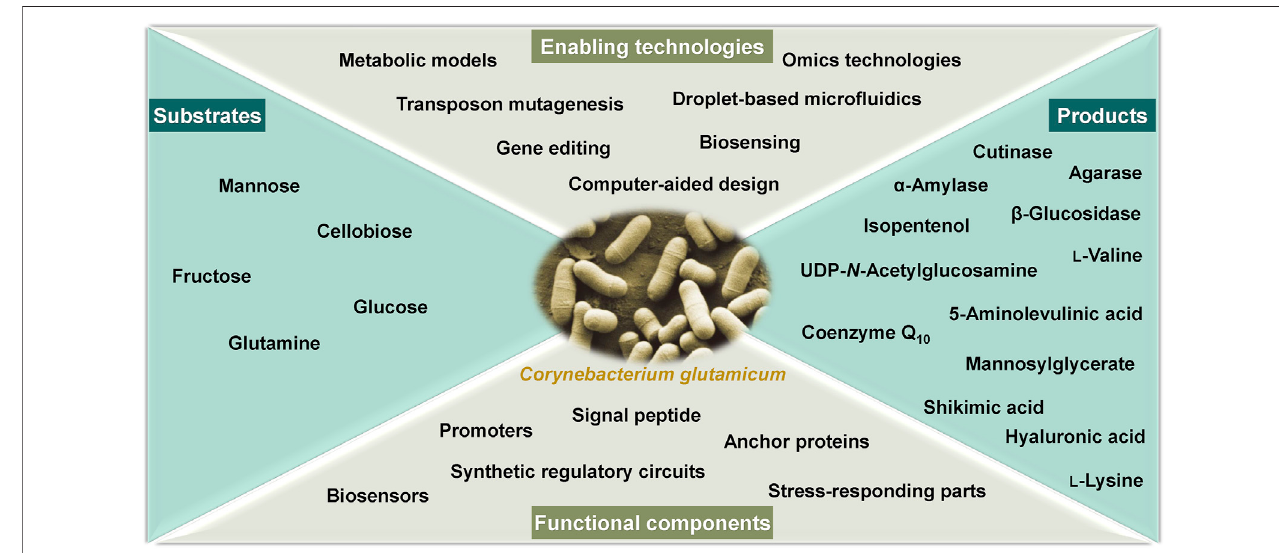
FIGURE 1 | A general categorization of the keywords of the articles collected in this Research Topic.